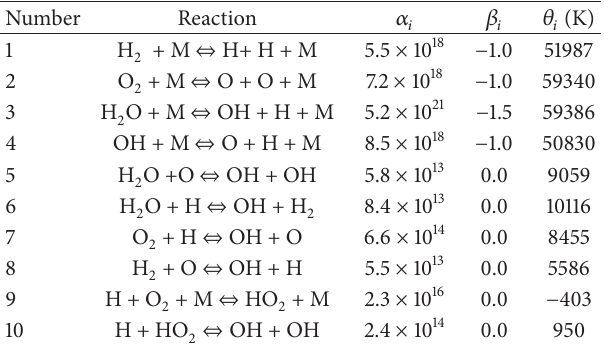
Table 1: Modified Evans-Schexnayder reaction model , 𝑘 𝑓 in cm 3 /mole ⋅ s. 𝑀 is the third body with an efficiency = 1 for all species and 𝜃 𝑖 = 𝐸 𝑎 / 𝑅